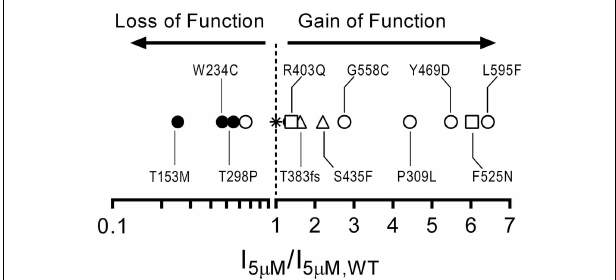
FIGURE 6 | Gain-of-function/loss-of-function continuum for cone CNG channel disease-associated mutations and polymorphisms based on current densities at a physiological concentration of cGMP. Plot comparing 5 µ M current density ratios for CNGB3 disease associated mutations and CNG channel polymorphisms with wild type A3 + B3 channels (star). The plot includes CNGB3 disease-associated mutations described here (open circles) and several CNGB3 disease-associated mutations described previously (Peng et al., 2003b—open triangles; Bright et al., 2005—open squares). Channels with a current-density ratio greater than 1.0 are predicted to generate an elevated photoreceptor dark current compared to wild type A3 + B3 channels and thus can be characterized as having a putative gain-of-function phenotype. Conversely, channels with a current-density ratio less than 1.0 are predicted to generate an attenuated photoreceptor dark current compared to wild type channels and can thus be characterized as having a putative loss-of-function